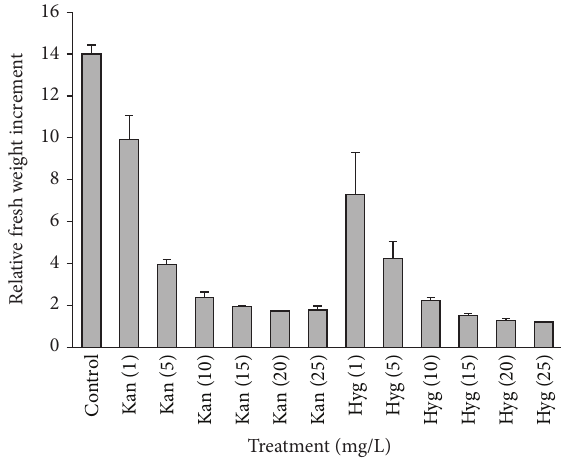
Figure 1: EM sensitivity to the selective agents. Kan: kanamycin, Hyg: hygromycin. Data were collected after 3 subcultures (6 weeks) and the values for the 5 embryogenic lines were